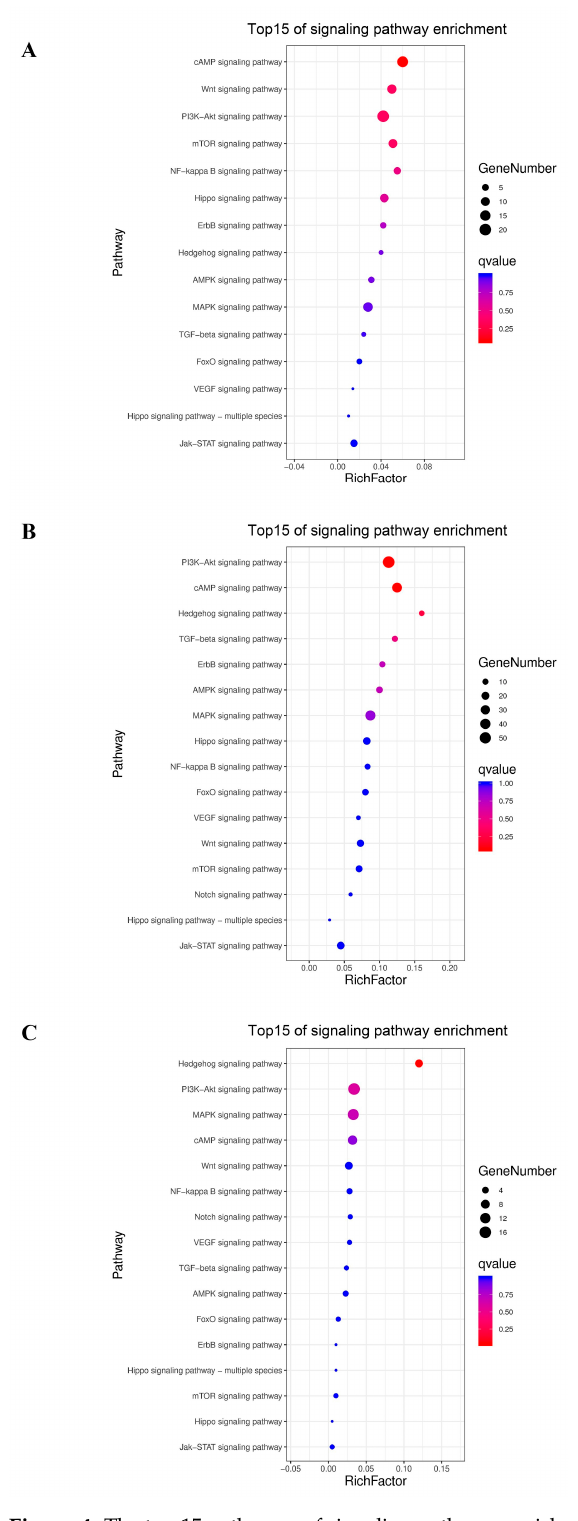
Figure 4. The top 15 pathways of signaling pathway enrichment test in three comparison groups. ( A )